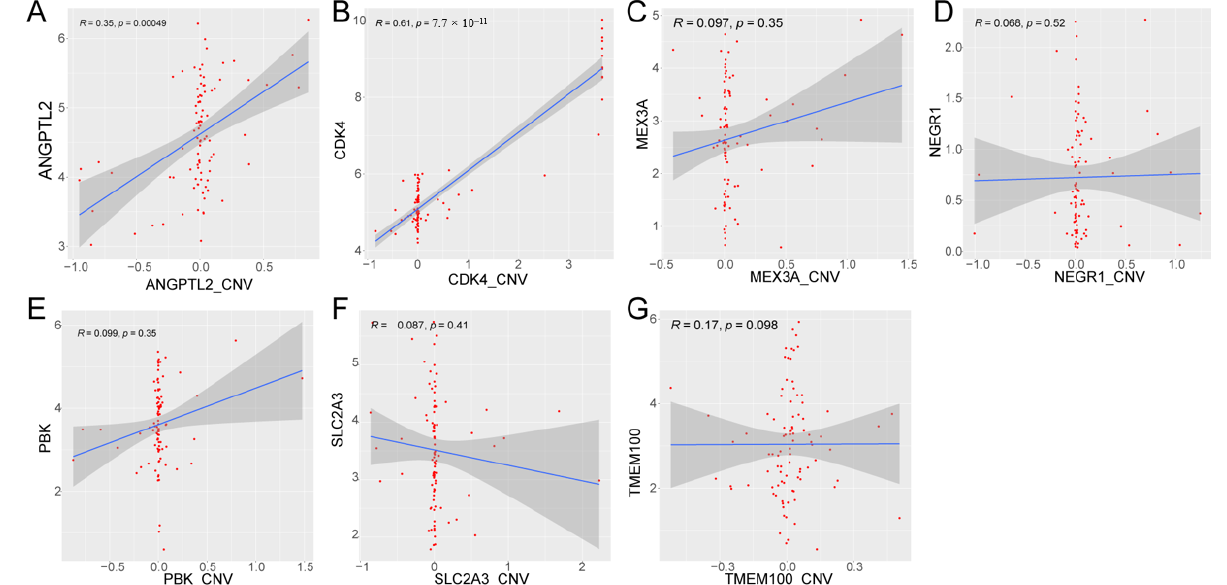
Figure 9. Correlation between prognostic gene expression and CNV: ( A ) correlation scatter plot of ANGPTL2 expression and CNV; ( B ) correlation scatter plot of CDK4 expression and CNV; ( C ) correlation scatter plot of MEX3A expression and CNV; ( D ) correlation scatter plot of NEGR1 expression and CNV; ( E ) correlation scatter plot of PBK expression and CNV; ( F ) correlation scatter plot of SLC2A3 expression and CNV; and ( G ) correlation scatter plot of TMEM100 expression and CNV.